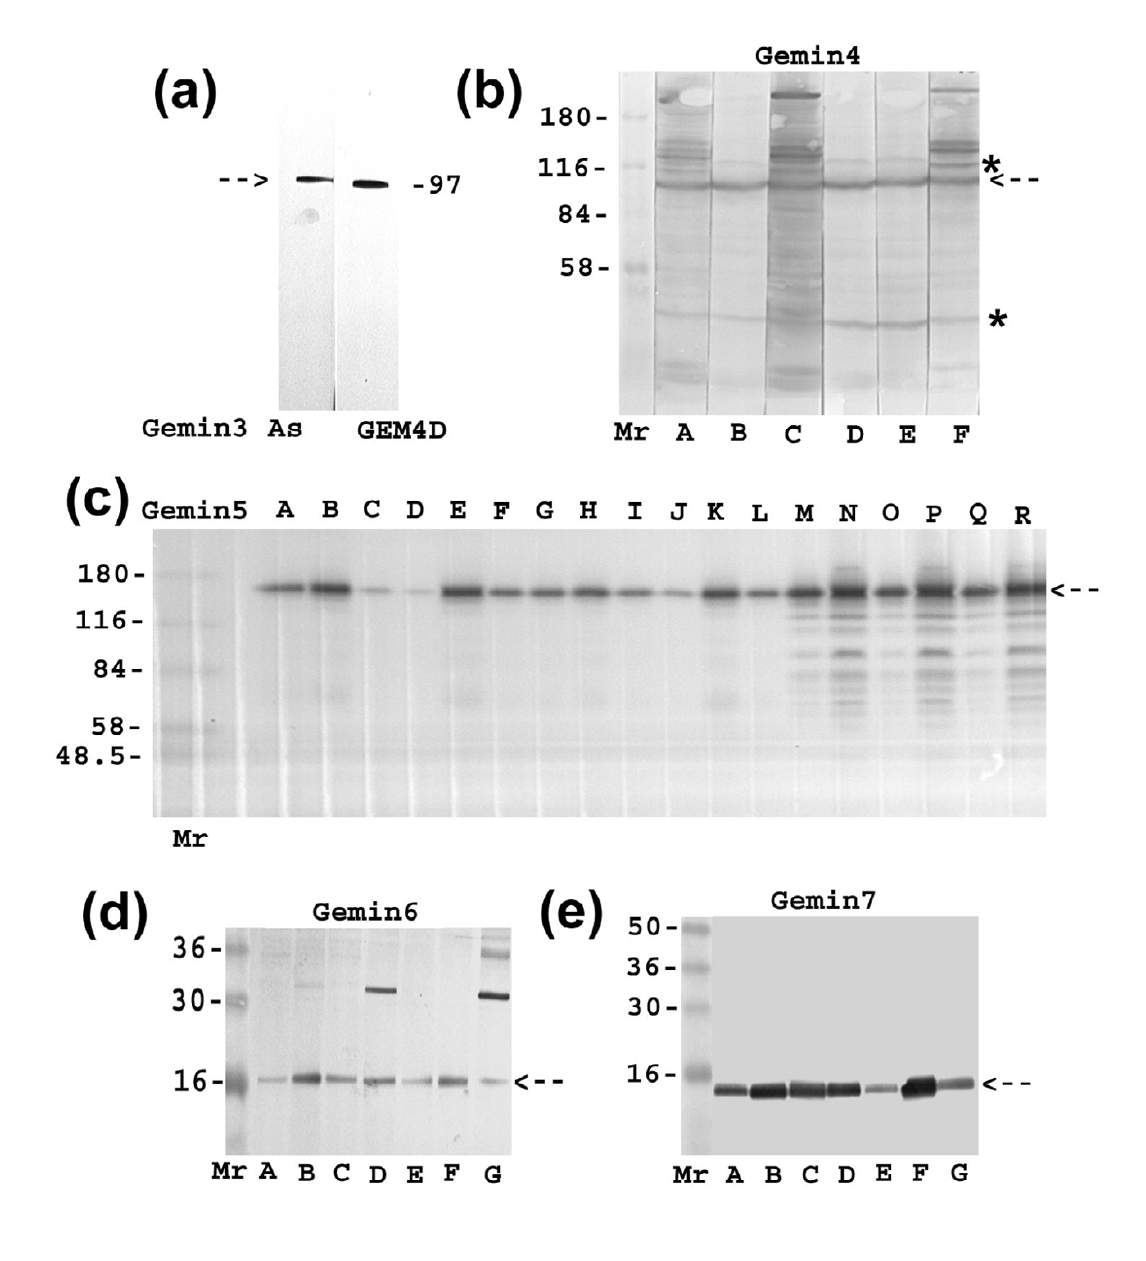
Figure 1 Characterization of gemin antibodies by western blots of total HeLa cell proteins . An SDS extract of HeLa cells was run as a horizontal strip alongside Mr markers on SDS-PAGE and transferred to nitrocellulose membranes by electroblot- ting. 7% acrylamide was used for (a)-(c) with prestained Sigma markers and 14% for (d) and (e) with prestained SeeBlue mark- ers. The blot was either cut into vertical lanes or, in (c) only, used directly on a 28-lane miniblotter apparatus. In each case, the main antigen band is shown as a broken arrow. (a) gemin3 antiserum stains a single protein of about 102 kD (97 kD gemin4 is shown as a marker). (b) the panel of 6 gemin4 mAbs all stain a band of 97 kD, but 3 of them (GEM4A, C and F) cross-react with several higher Mr proteins. Non-specific bands (*) are due to the secondary antibody system. (c) the 12 mAbs against the gemin5 N-terminal region stain a single band consistent with the 167 kD expected for gemin5 and the 6 mAbs against the C- terminal region stain the same band, together with a ladder of smaller bands that may be degradation products. (d) The 7 gemin6 mAbs all stain a band of 16 kD, but 2 of them cross-react with a 32 kD band. (e) All 7 gemin7 mAbs stain a single band of 15